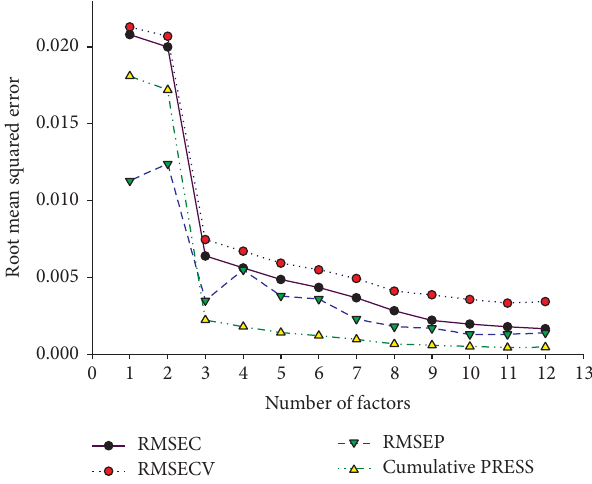
Figure 3: Calibration characteristics versus number of latent factors forthecontentofcryptotanshinone.RMSEC,RMSECV,andRMSEP represent the root mean square error for calibration, cross valida- tion, and prediction, respectively. PRESS means predicted residual error sum square.